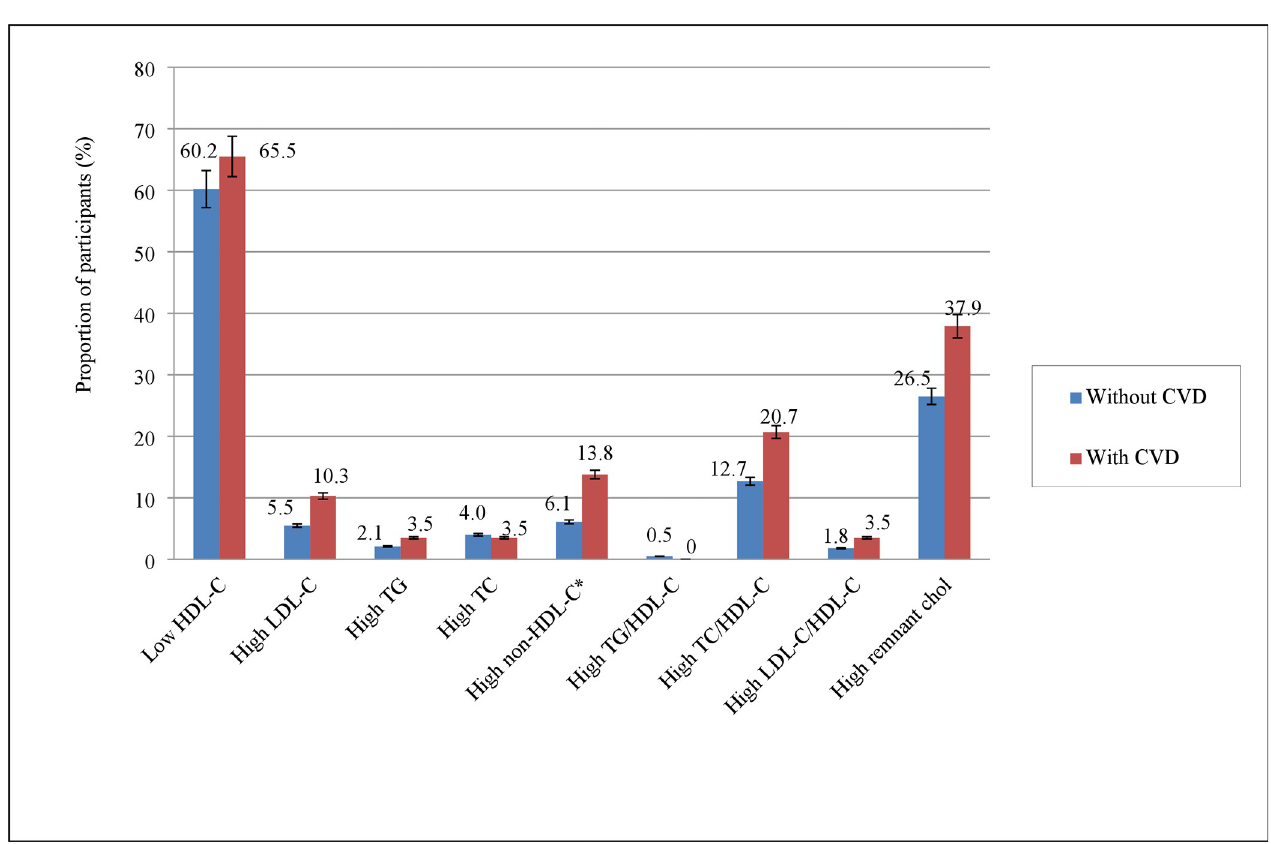
Fig 1. Prevalence of high levels of each of the lipid metrics, and low levels of HDL-C categorized by the presence or absence of reported self-reported CVD in the study participants. � P < 0.05; data expressed as % with 95% CIs; CVD: cardiovascular disease; HDL-C: high density lipoprotein cholesterol; LDL-C: low density lipoprotein cholesterol; TG: triglyceride; TC: total cholesterol; chol: cholesterol; CIs: confidence intervals.